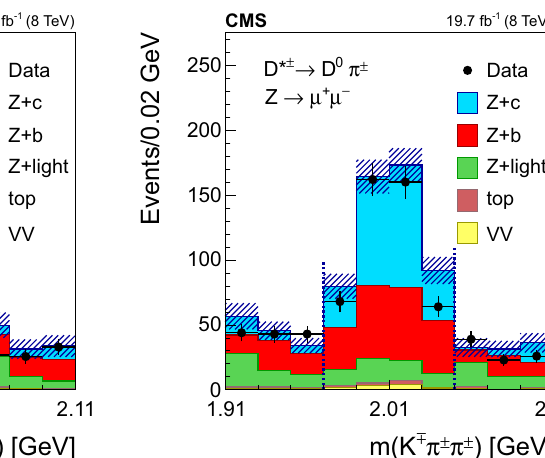
Fig. 3 The invariant mass distribution of the three-track system com- posed of a two-prong secondary vertex and a primary particle for events selected in the D ∗ ( 2010 ) ± mode, in the dielectron (left) and dimuon (right) channels. The mass assigned to each of the three tracks is explained in the text. The contributions from all processes are esti-